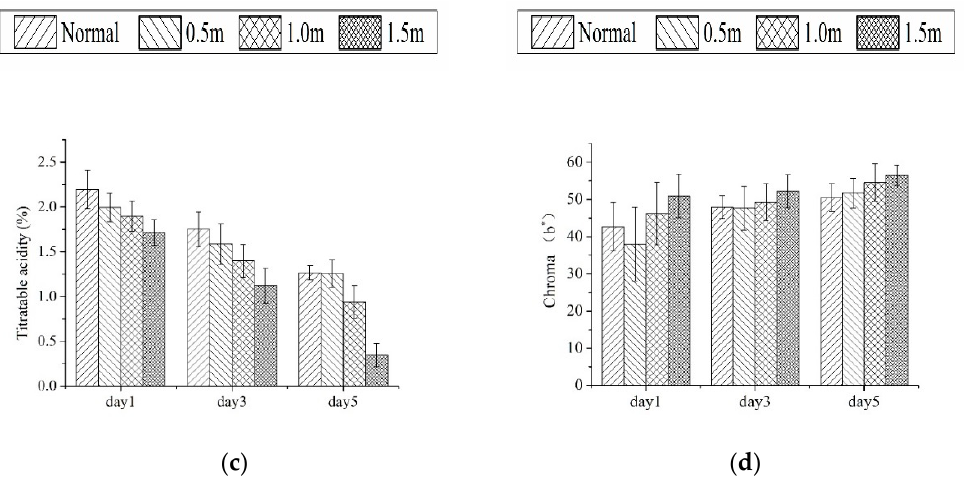
Figure 2. Changes in quality attributes of mango samples both in normal and damaged stages ( a ) pulp firmness, ( b ) total soluble solids (TSS), ( c ) titratable acidity (TA) and ( d ) chroma ( ∆ b*).